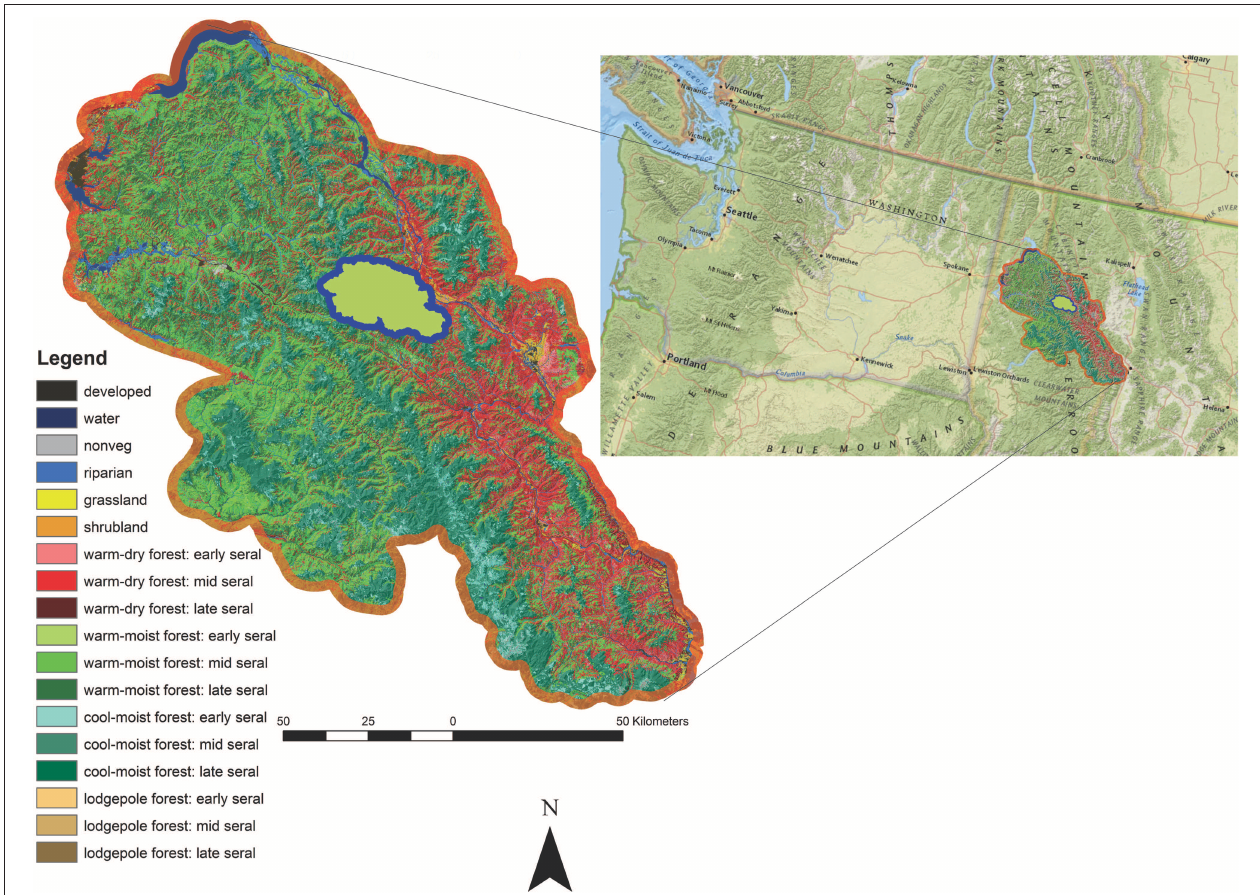
FIGURE 2 | Study area orientation map. The case study landscape consists of a natural ecological unit in the Bitterroot Mountains of Idaho and Montana, USA (inset landscape with orange border). The Prospect Creek sub-landscape, where much of the spatial analysis is illustrated is shown as a green polygon with blue